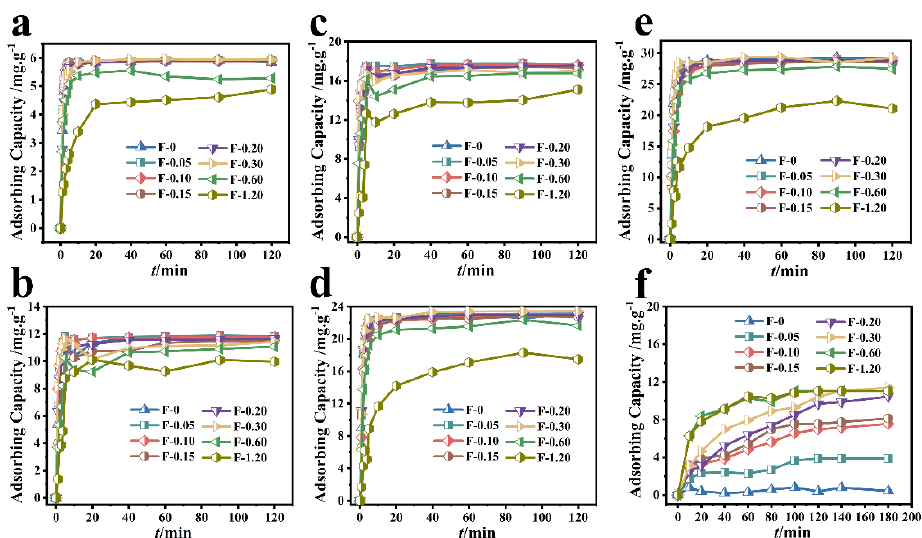
Figure 3. Different composite membranes adsorbed different initial concentrations of Cr (VI). ( a – e ) the initial concentrations of 20, 40, 60, 80, and 100 mg/L, respectively. Reaction conditions: Cr (VI) (60 mL), adsorbent (0.2 g). ( f ) The adsorption results of different composite membranes on RhB. Reaction conditions: RhB (40 mg/L, 60 mL), adsorbent (0.2 g).